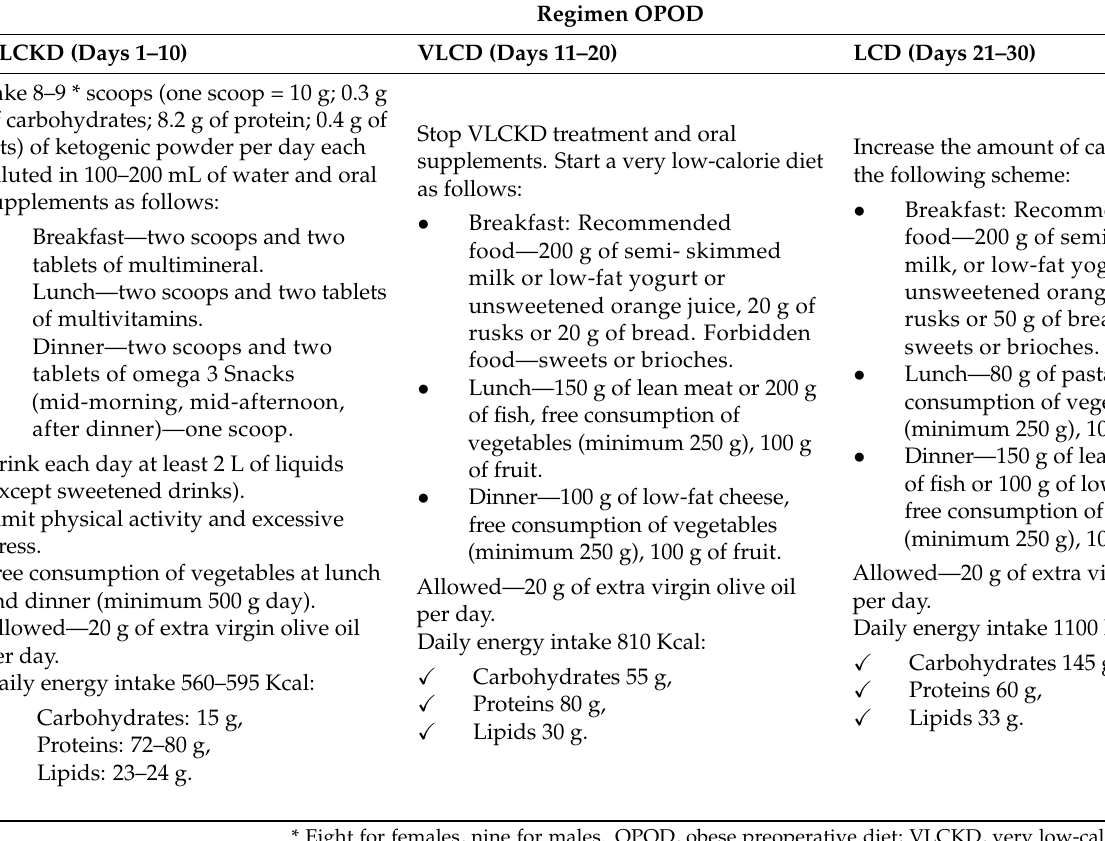
Table 1. The obese preoperative diet (OPOD) [48]. Regimen